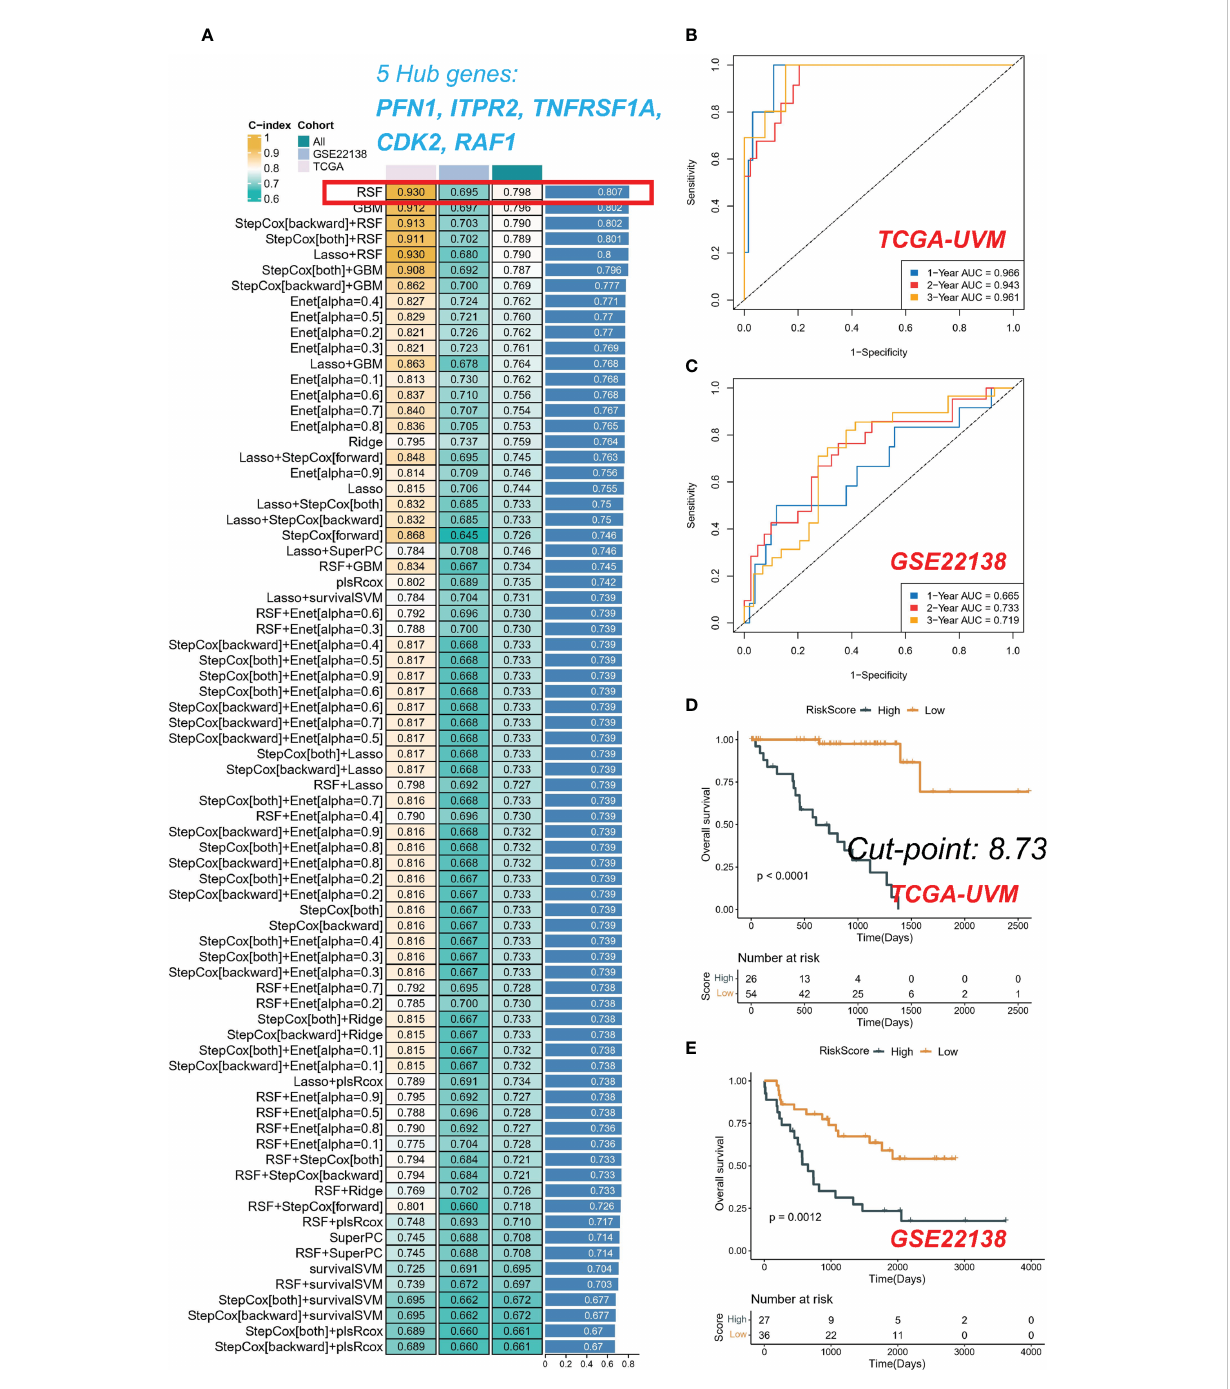
FIGURE 5 Integrative construction of a consensus signature. (A) C-indices of 76 kinds of prediction models in three cohorts. ROC analysis at 1, 2, and 3 years in TCGA-UVM (B) and GSE22138 (C) . Kaplan-Meier curves of OS in TCGA-UVM (D) and GSE22138 (E)